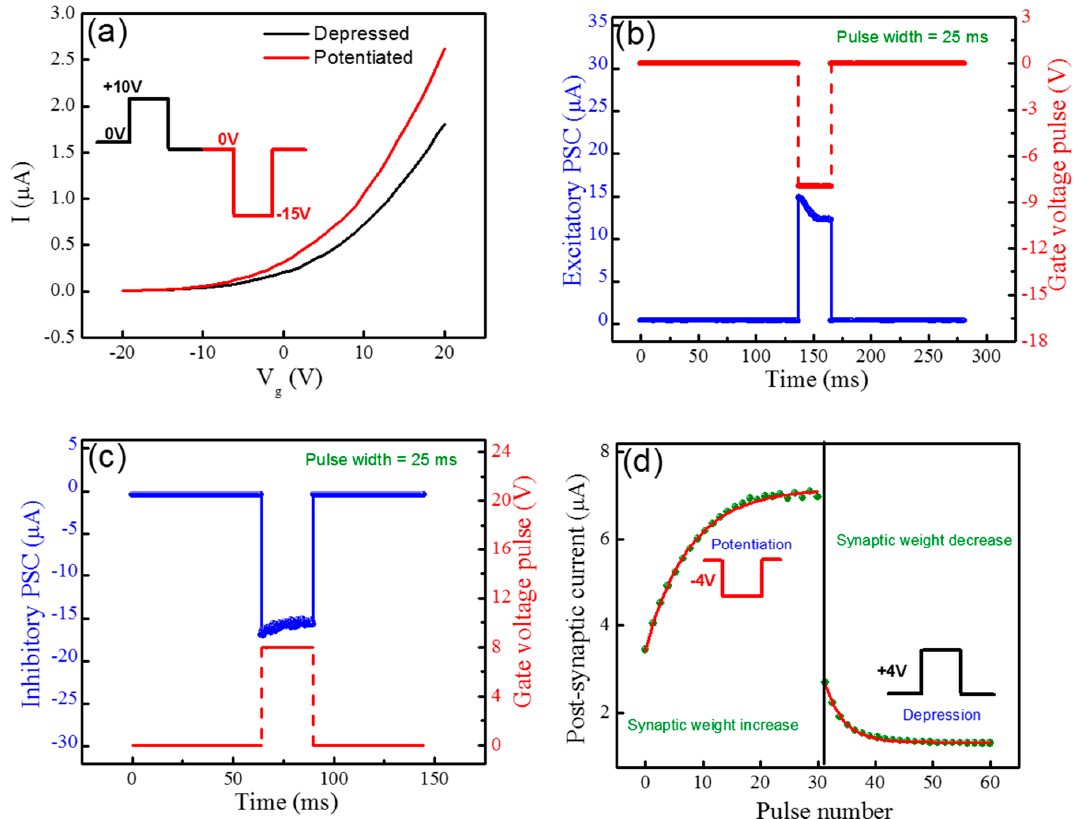
Figure 4. ( a ) Change in the threshold voltage of MoTe 2 FET after 50 consecutive pulses to the gate terminal. ( b ) The excitatory post-synaptic current (EPSC) changes in MoTe 2 synaptic transistor at negative gate pulse. ( c ) The inhibitory post-synaptic current (IPSC) changes in the MoTe 2 synaptic transistor at positive gate pulse. ( d ) The application of negative and positive voltage pulses (V = − 4 V and +4 V) demonstrating exponential trend in PSC, showing long-term depression (LTD) and long-term potentiation (LTP) processes, respectively.